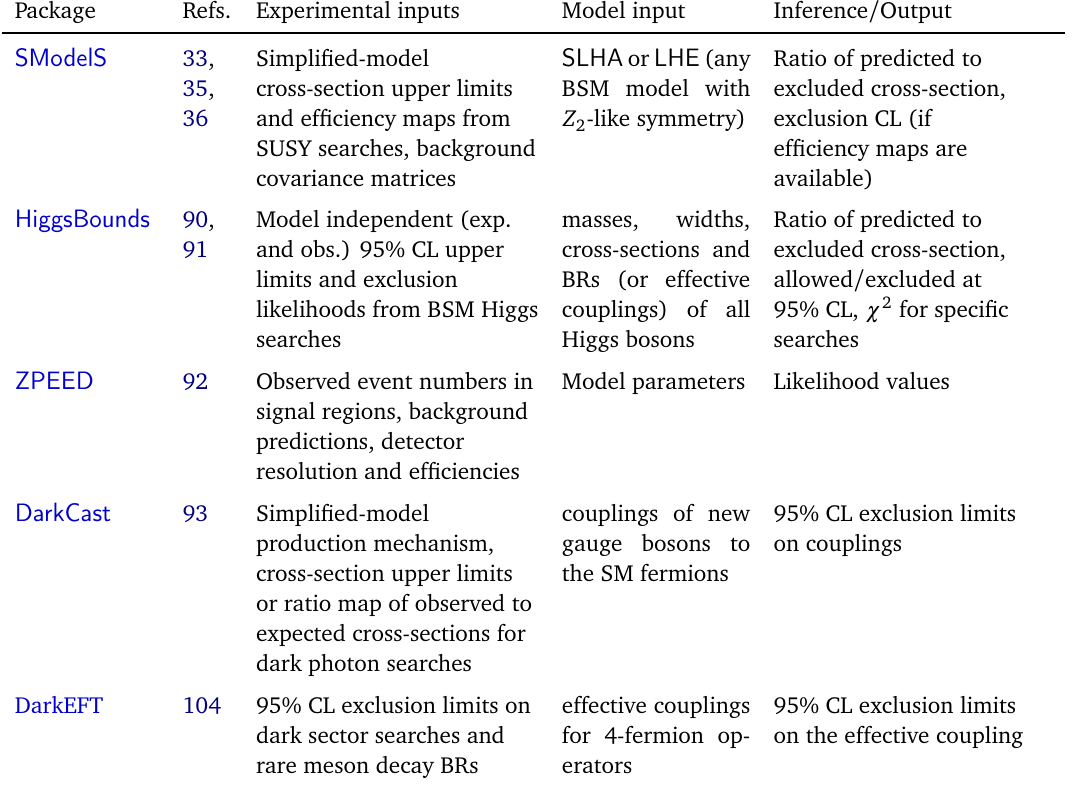
Table 2: Summary of public frameworks for the reinterpretation of searches and measurements (continued). The columns summarise the major inputs from the ex- periments used for the reinterpretation, the model inputs, and the principle outputs in terms of performing statistical